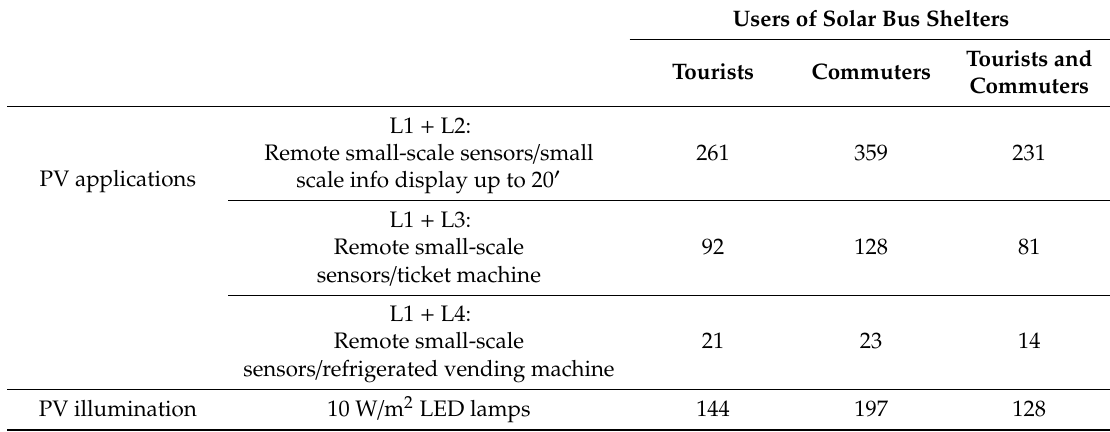
Table 4. Solar bus shelters scenarios based on the PV capability and the estimated use.